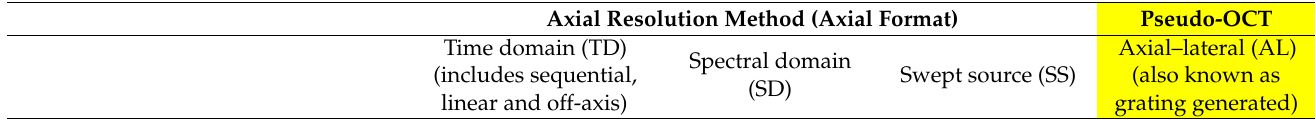
Figure 1. Illustration of lateral area illuminated and imaged for each lateral format. Table 1. Categorisation of optical coherence tomography systems by combination of lateral and axial resolution methods, with seminal early paper identified and description of prevalence in general clinical practice. The area highlighted in green is the scope of this